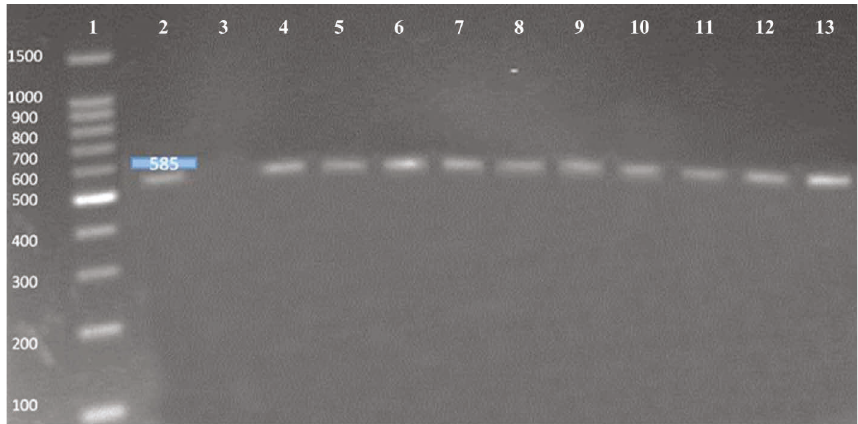
Figure 6: Molecular detection of PAP virulence gene (585 bp). Number 1: 100bp DNA ladder; number 2: positive control; number 3: negative control; number 4 to 13: positive